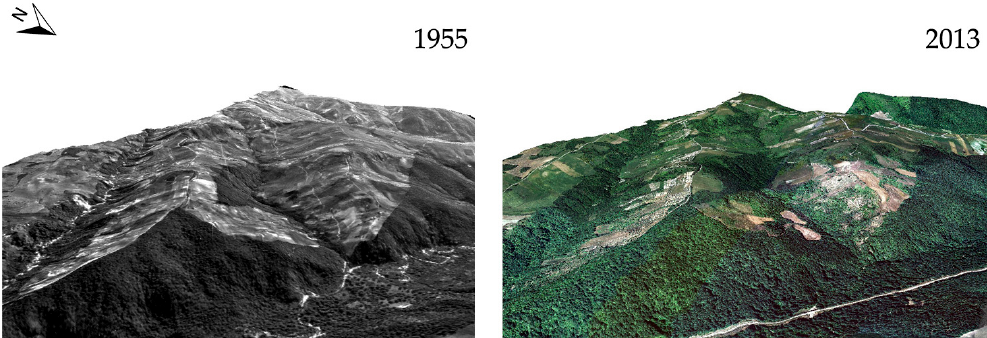
Figure 7. Three-dimensional visualization of the landscape.